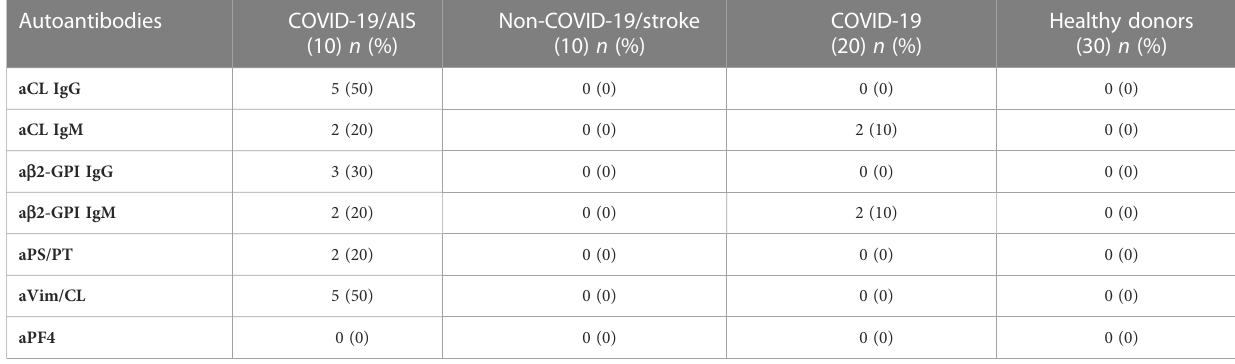
TABLE 3 Prevalence of autoantibodies in patients and healthy